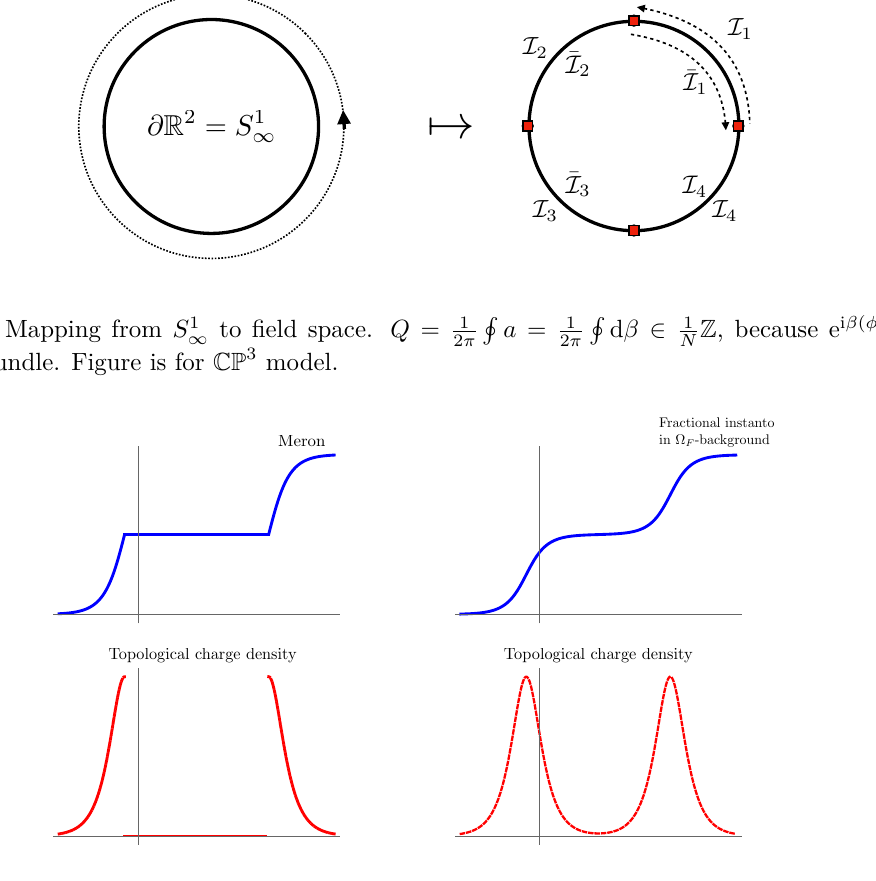
in figure 7. a) Meron data is piecewise ∞ background. A fractional instanton pair F